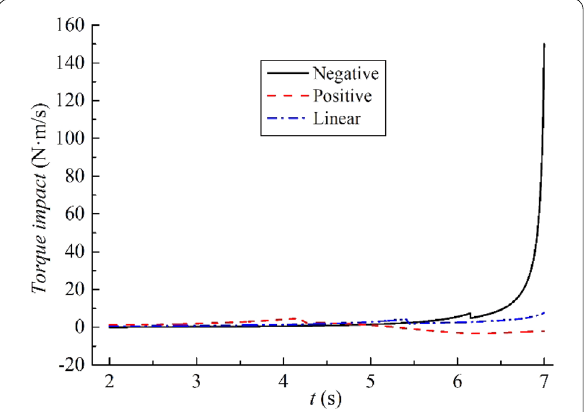
Figure 7 Torque impact under different